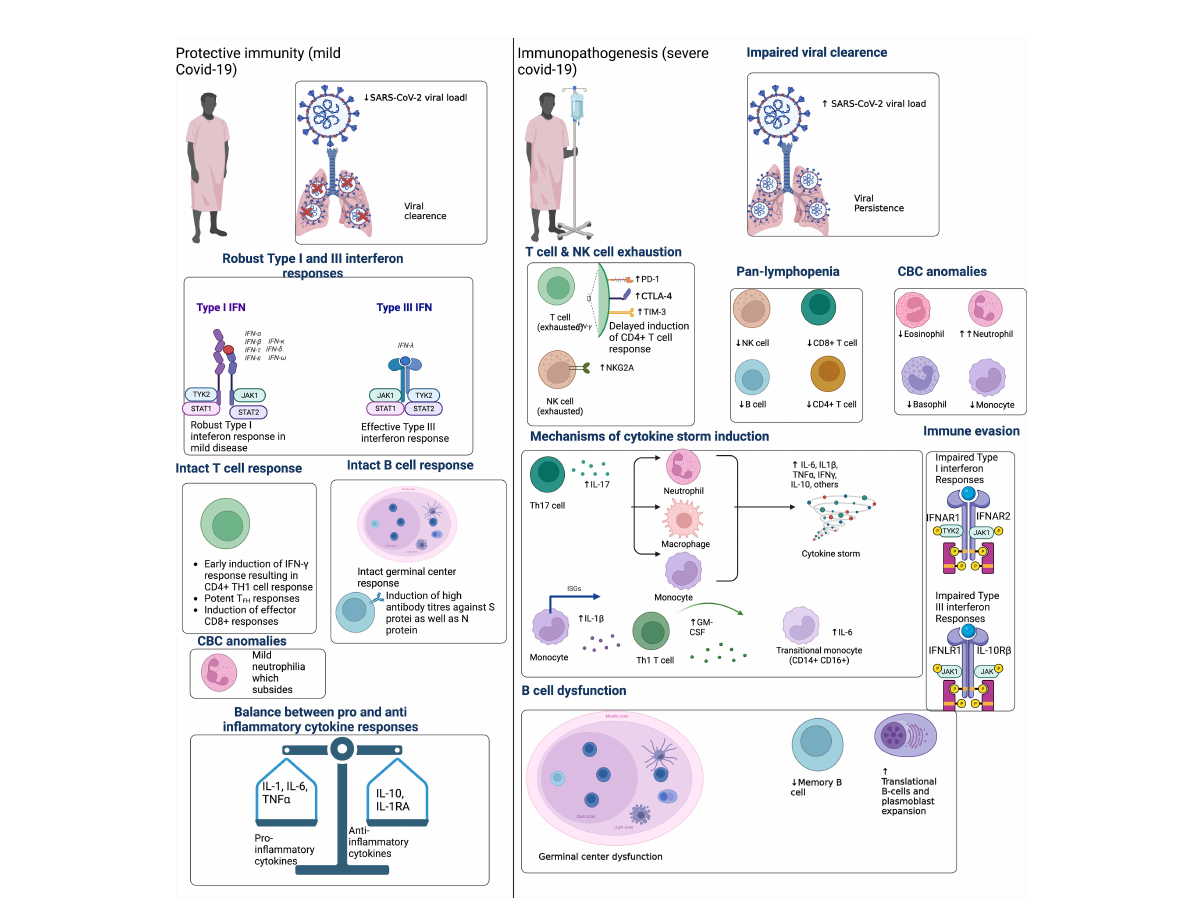
FIGURE 1 Protective immunity to SARS-CoV-2 infection is characterized by early and robust type I and III IFN. This corresponds to the early recruitment and expansion of T-cell responses, which correlates with SARS-CoV-2 viral clearance and asymptomatic or mild COVID-19. Protective immunity also features early plasmablast expansion and intact B-cell germinal center responses. Given the importance of IFN response in protective immunity, SARS-CoV-2 can evade IFN responses to delay the recruitment of adaptive immunity. Immunopathogenesis is therefore characterized by delayed T-cell activation, a consequent delay in viral clearance and overactivation of innate immunity. Innate immune cells then overproduce pro-in fl ammatory cytokines that spillover into the systemic circulation, causing a cytokine storm. Concomitantly, exaggerated neutrophil responses, platelet activation, and endothelial in fl ammation (i.e., endotheliosis) precipitate a hypercoagulable state manifesting clinically as the thrombotic microangiopathy that affects critically ill COVID-19 patients. Adapted from “ Immune Mechanisms Affected by COVID-19 ” , by BioRender.com (2022). Retrieved from